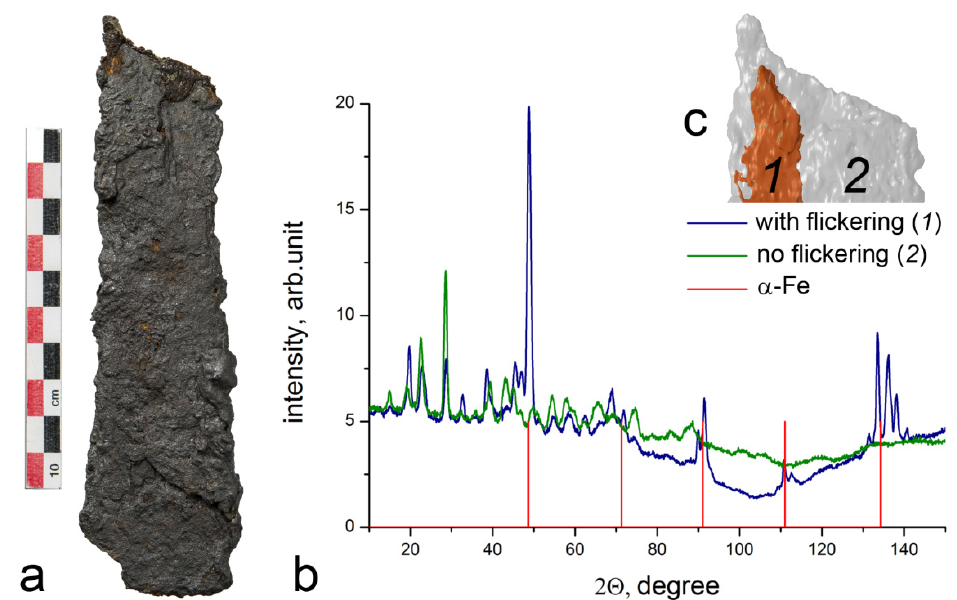
Figure 7. Detection of metallic iron in an artifact from Chernaya Mogila: ( a ) photograph of the object; ( b ) neutron diffraction pattern at two positions of the sample; the positions of the α -Fe lines are indicated; ( c ) reconstruction of the region of preservation of iron in the